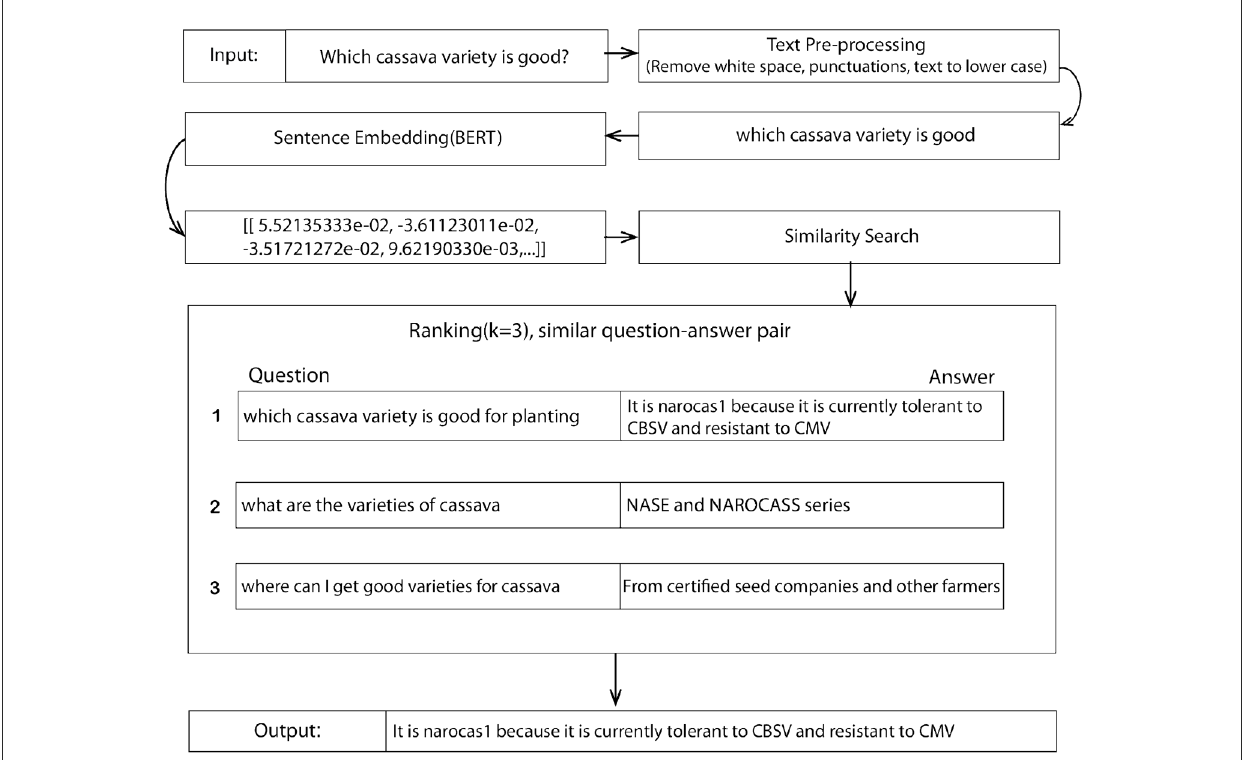
FIGURE2 The proposed retrieval-based architecture (RetBERT) with a sentence embedding and ranking given an example input and the resulting output.